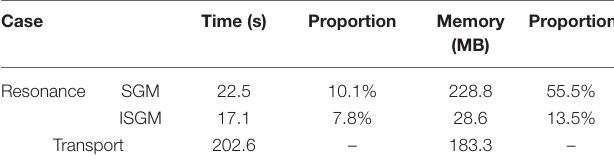
TABLE 7 | Calculation burden of UO 2